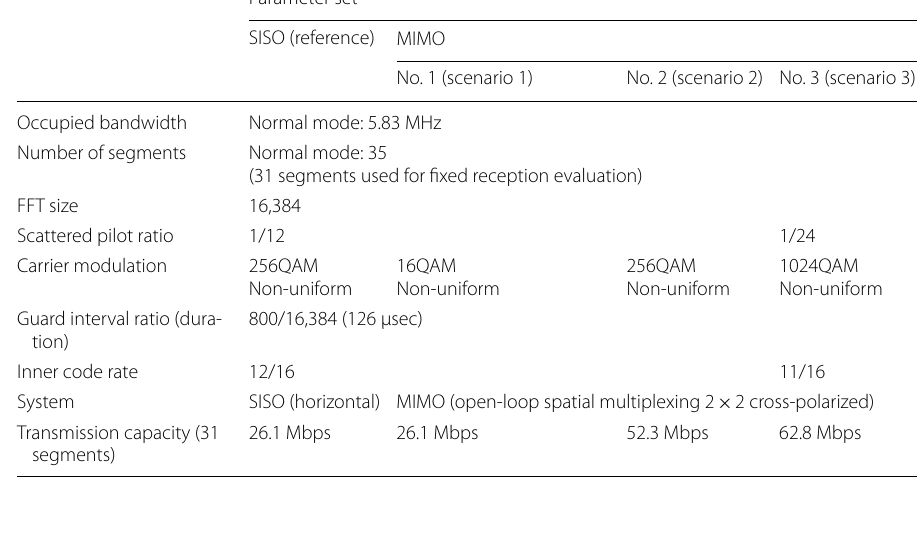
Table 4 Parameter sets for experiments